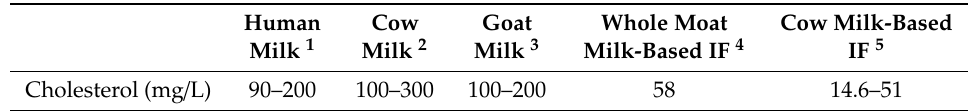
Table 3. Cholesterol concentration (mg / L) in human milk, cow milk, goat milk and whole goat milk-based infant